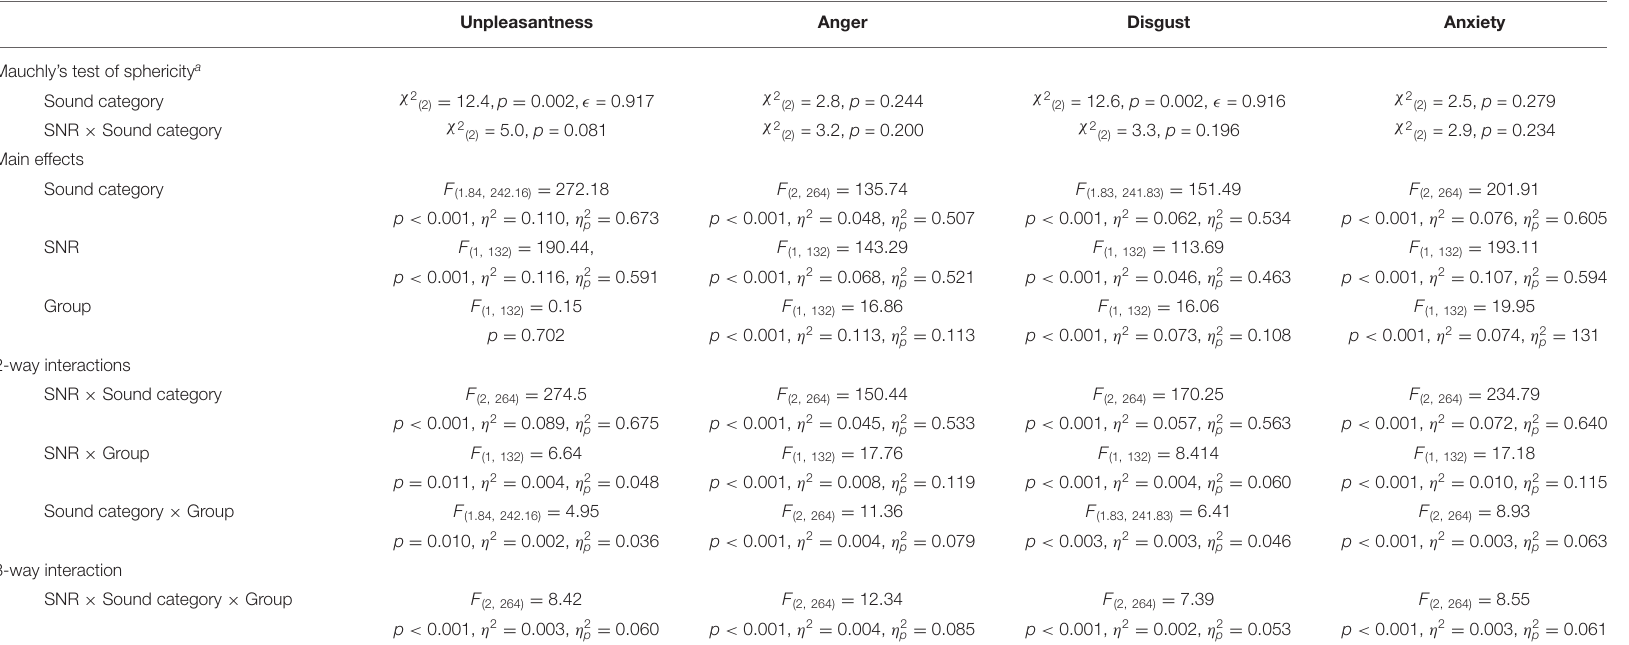
TABLE 1 | ANOVA results for emotional ratings before and after recognition threshold. Unpleasantness